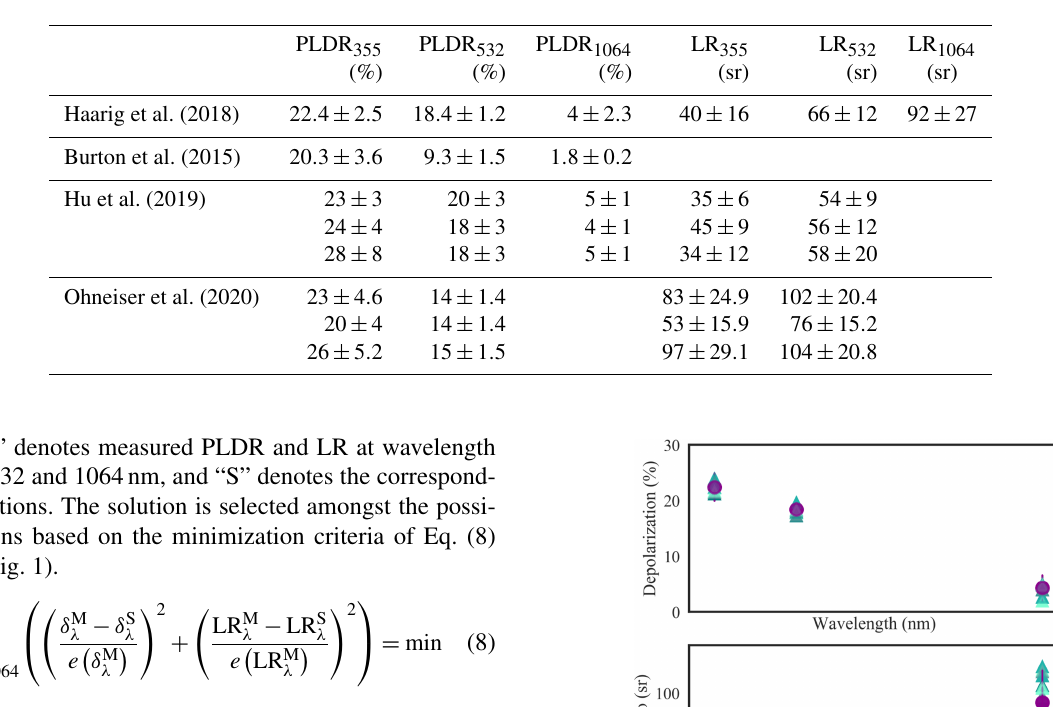
Table 2. LR and PLDR layer-integrated mean values at 355, 532 and 1064nm for the stratospheric smoke layer, on 22 August 2017, in Leipzig, Germany (Haarig et al., 2018). Also shown are the multi-wavelength observations of PLDR and LR reported in previous and later studies for stratospheric or tropospheric smoke particles exhibiting high PLDR values.